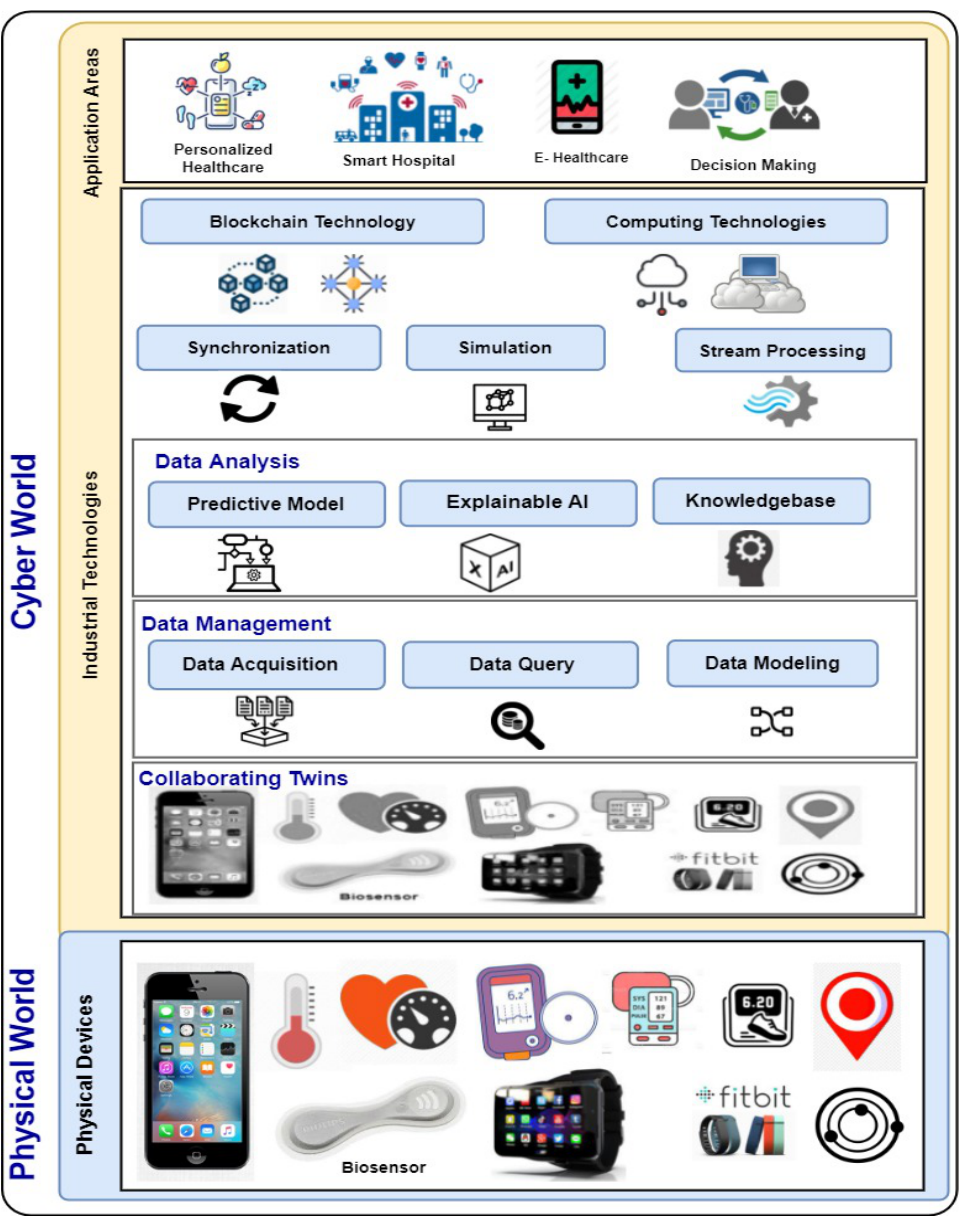
Figure 8. The reference framework of building PDT-based personalised healthcare